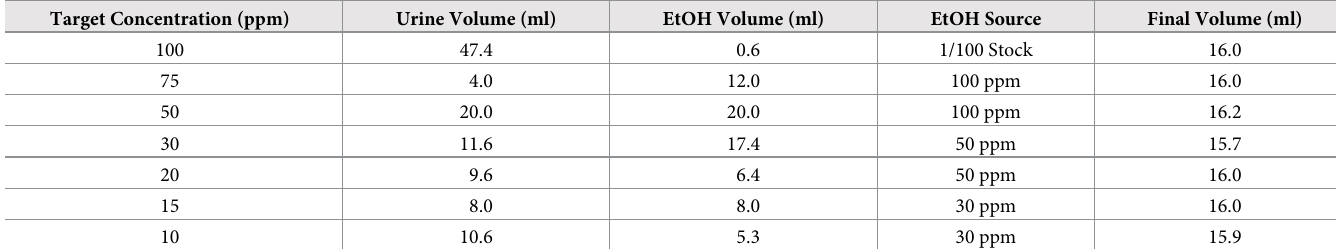
Table 4. Serial dilution of calibration standards.